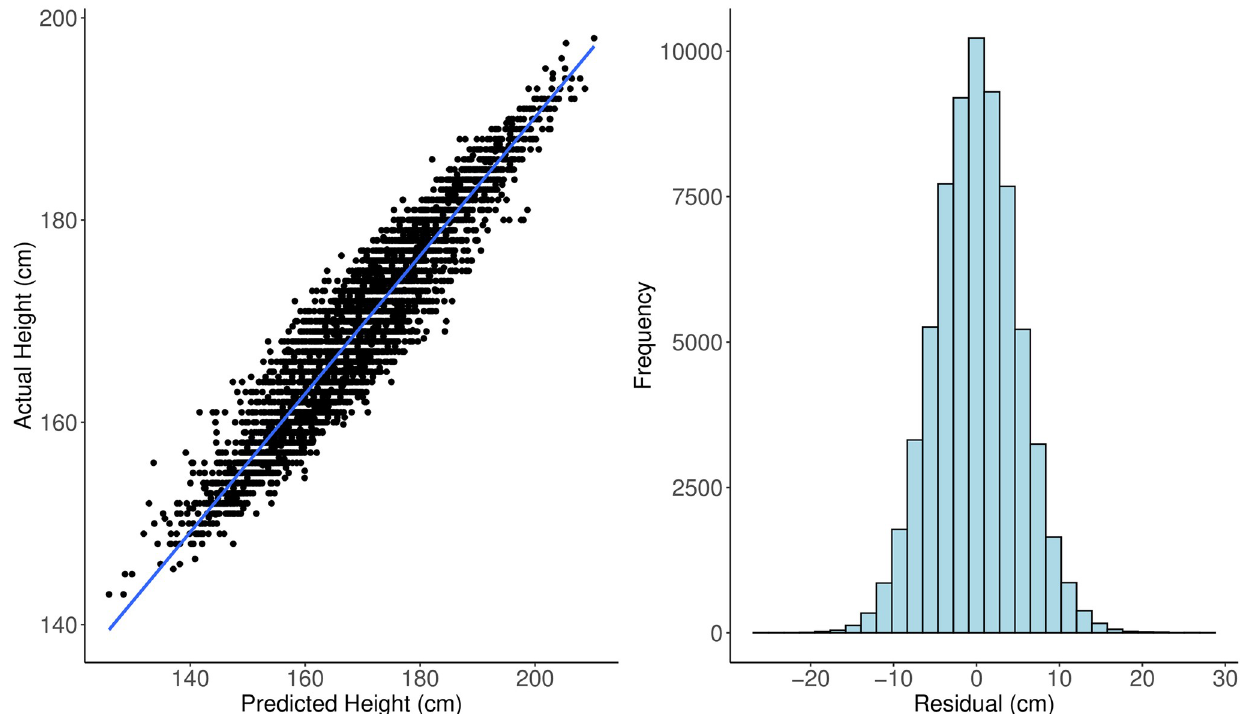
Fig 5. Left: actual height versus predicted height on 5000 random samples from the test set. A regression line with its 95% confidence band is also added on top of the dots. The correlation between actual height and predicted height is 0.9416. Right: histogram of the lasso residuals for height. Standard deviation of the residual is 5.05 (cm).